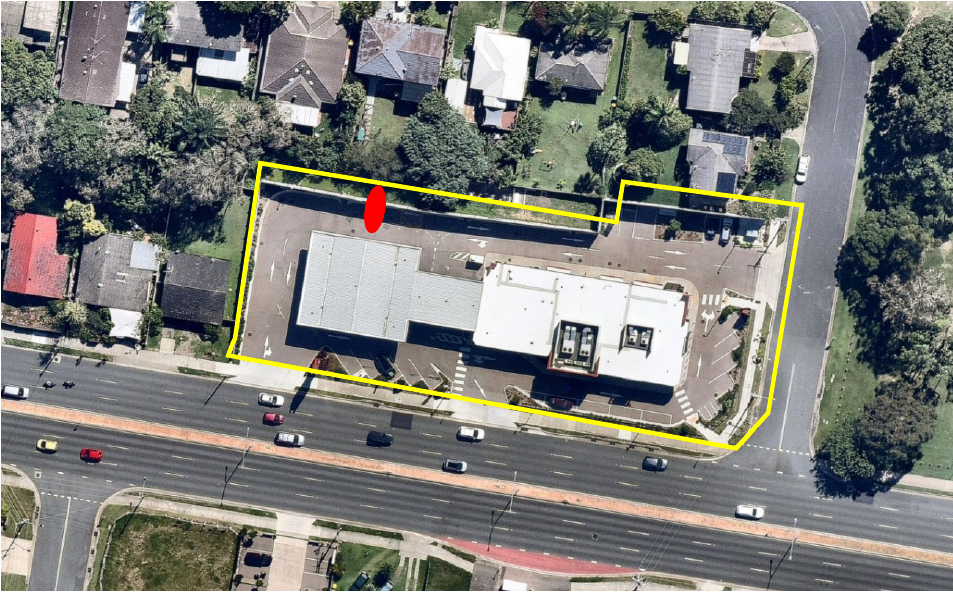
Figure 7. Southport field monitoring site (approximate site boundary shown by yellow line).